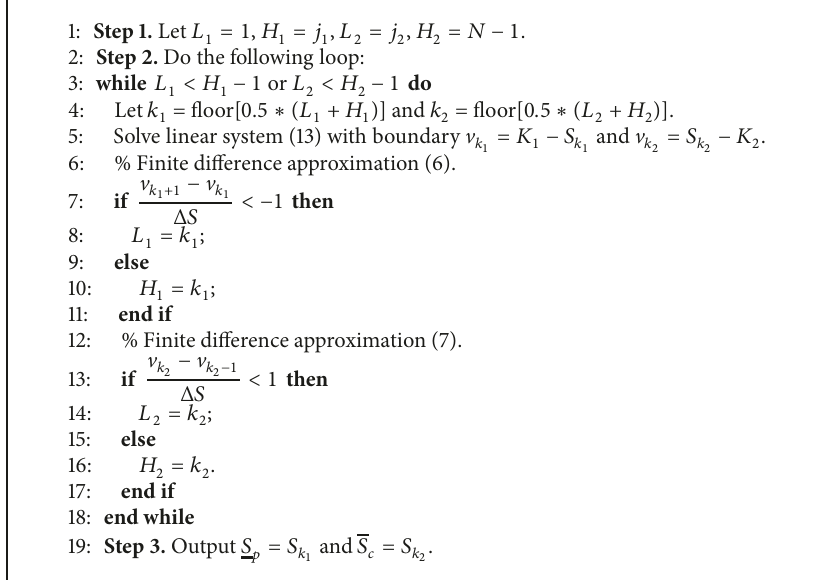
Algorithm 1: Algorithm for solving 𝑆 𝑝 and 𝑆 𝑐